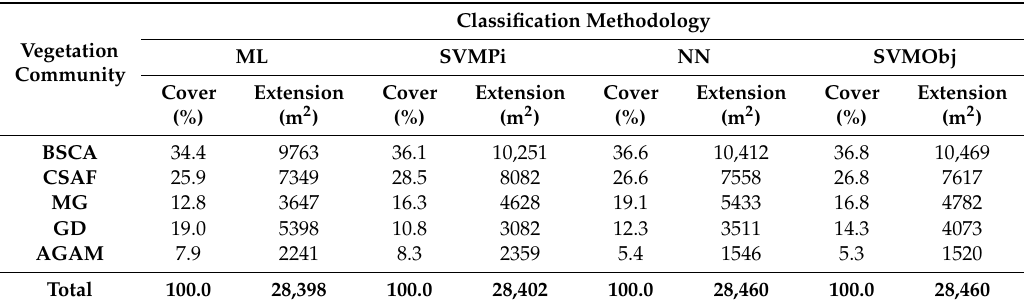
Figure 6. Object-based classification of the Casal Borsetti dune vegetation. ( a ) Nearest neighbor classification. ( b ) Support vector machine object classification. ( a1 , b1 ) Populus × canadensis tree classification. ( a2 , b2 ) Missed footpath classification. Table 2. Vegetation community cover and extension for each classification methodology. For abbreviations, see main